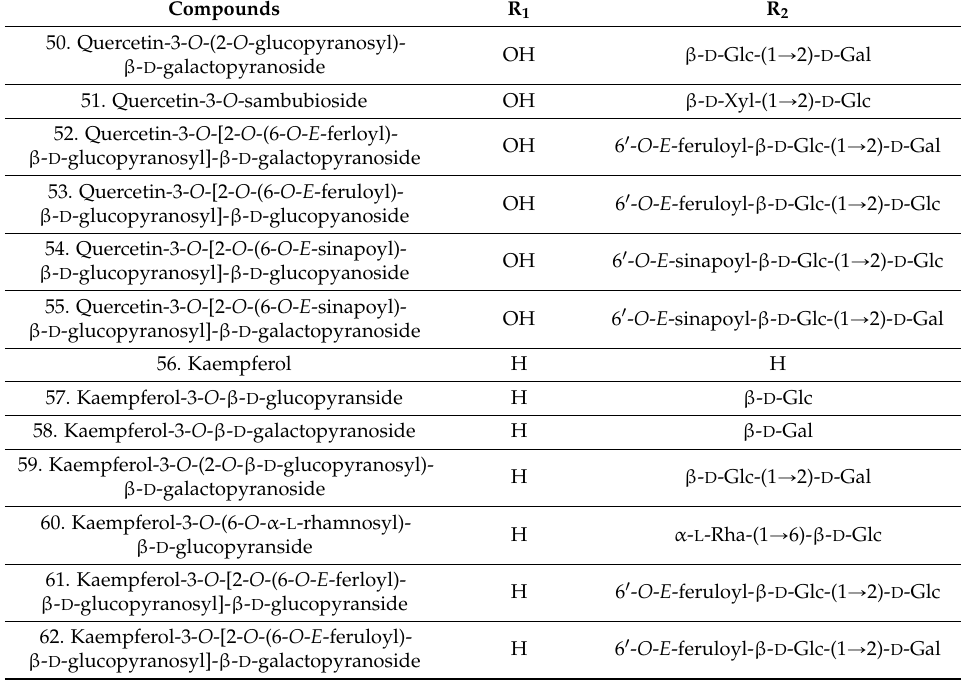
Figure 2. Chemical structures of flavonoids in H. diffusa .